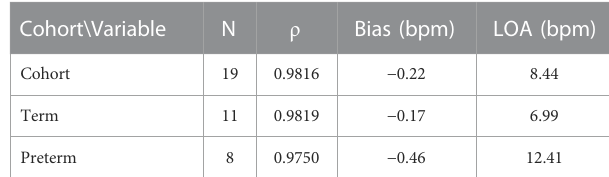
TABLE 2 Accuracy results when separated into sub-cohorts of term and preterm infants. Spearman ’ s correlation coef fi cient ( ρ ), bias and LOA are